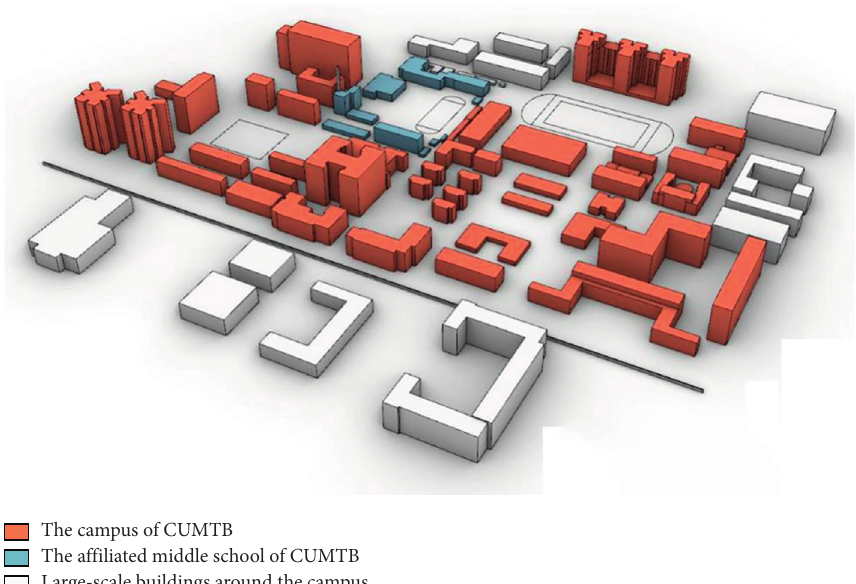
Figure 4: Computational geometry model of the CUMTB